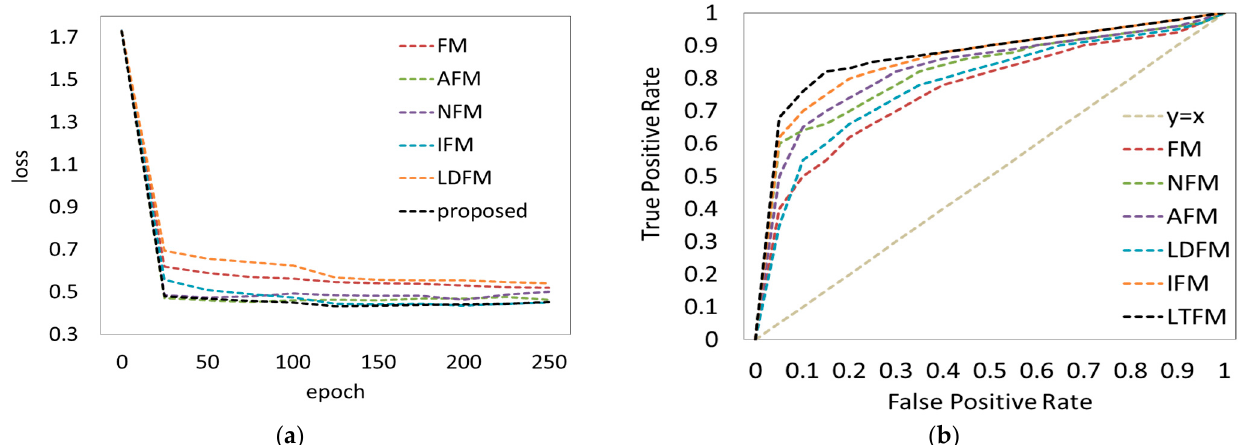
Figure 3. The performance for comparison FMs ( a ) comparison of model convergence ( b ) ROC curves of different comparison algorithms.